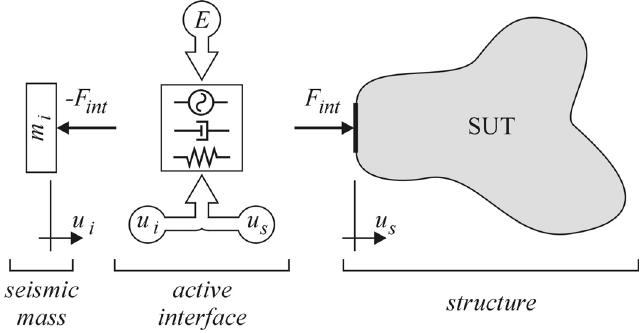
Fig. 7. Inertial shaker active interface model.